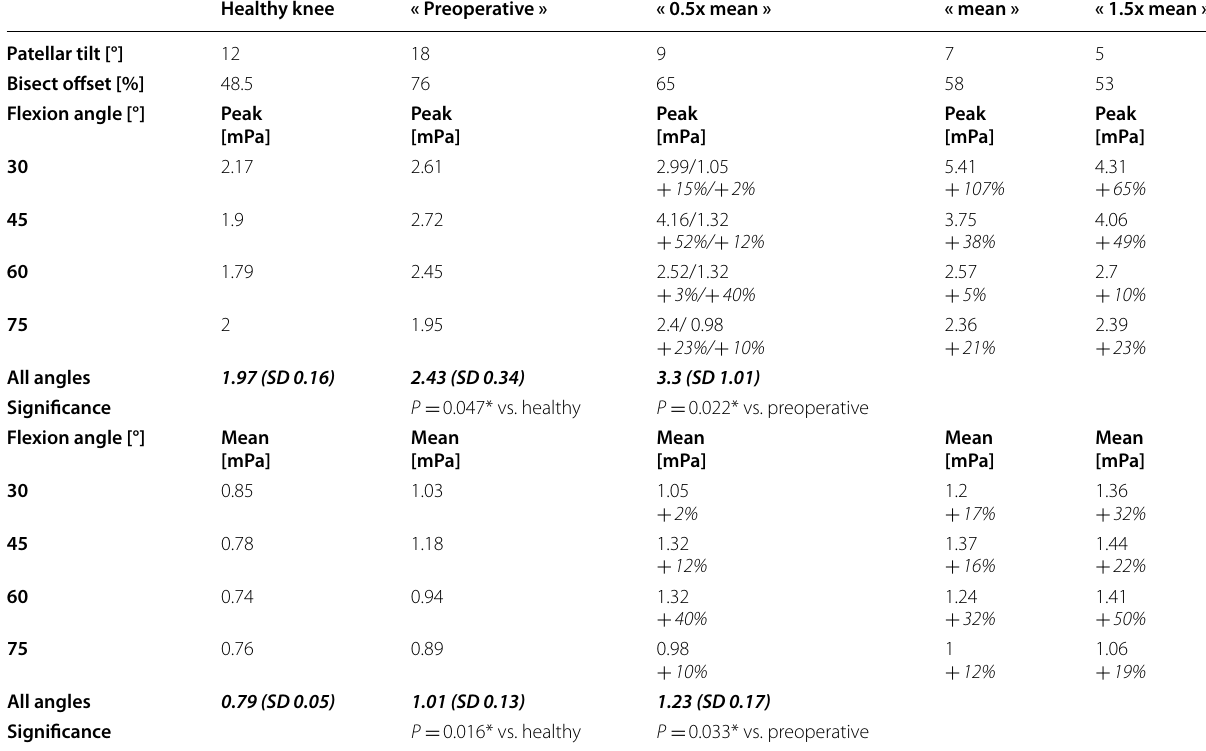
Table 1 Peak and mean contact pressure between the patella and the trochlea in the healthy knee and the trochleodysplastic knee are shown “preoperative” and after simulated surgery at different flexion angles. Additionally, the patellar tilt and bisect offset values are included. * Welch’s